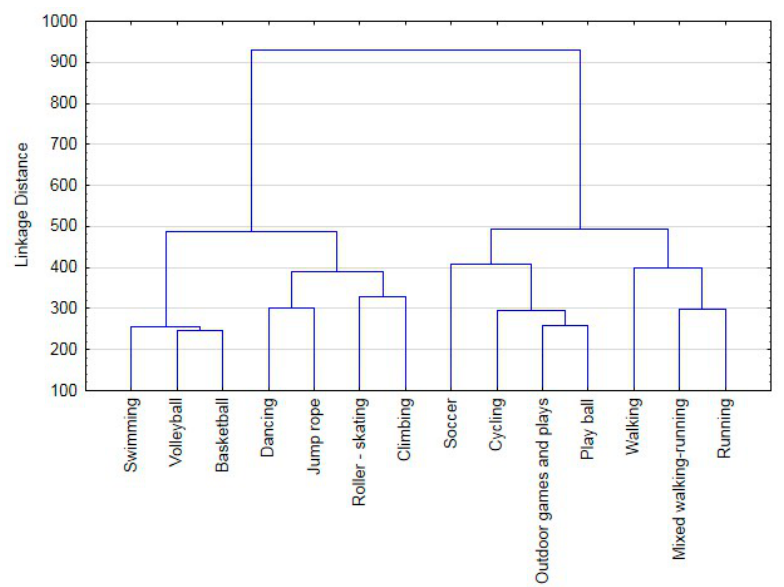
Figure A3. Tree diagram for cluster analysis of physical activities the children participated in. The cut-off point is at the distance of 450, clustering variables into four groups.